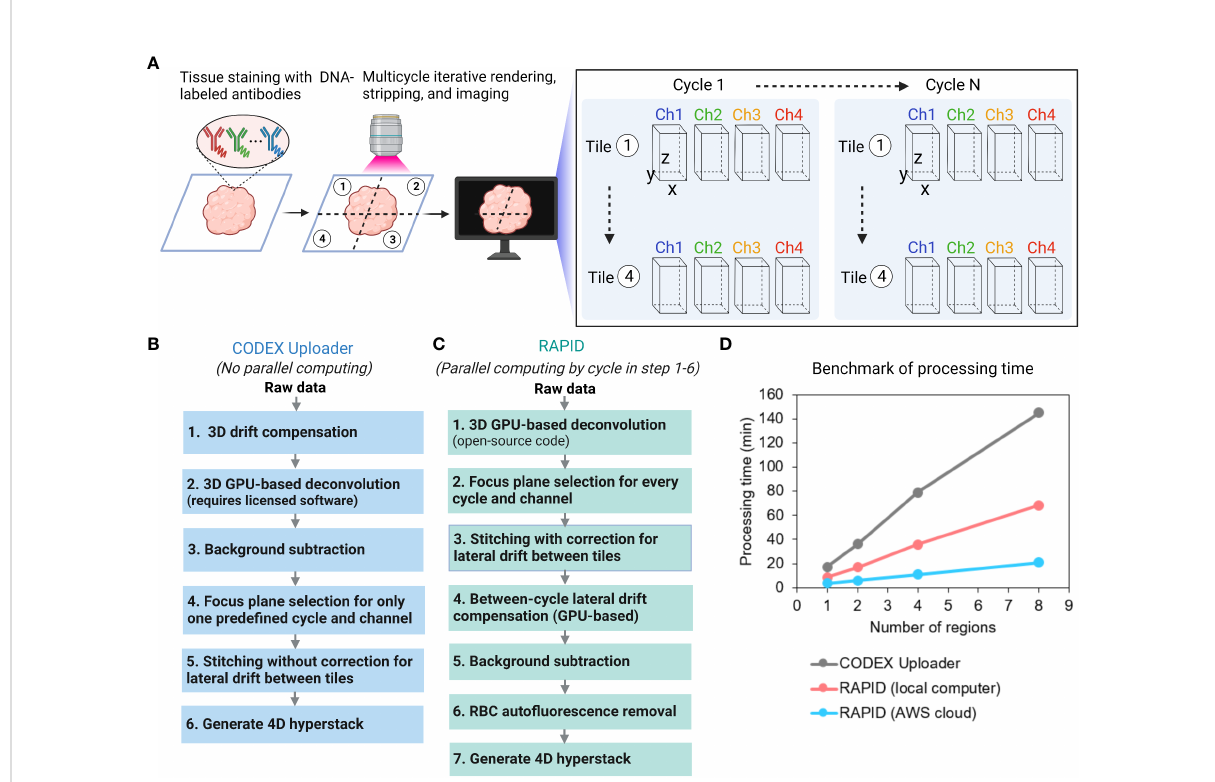
FIGURE 1 Overview of image processing methods for CODEX multiplexed imaging data. (A) CODEX work fl ow and the structure of a raw imaging dataset. (B) Overview of the CODEX Uploader pipeline. (C) Overview of the RAPID pipeline. (D) Plot of processing time versus number of regions analyzed with the two pipelines on a local system and for the RAPID run on a cloud-based